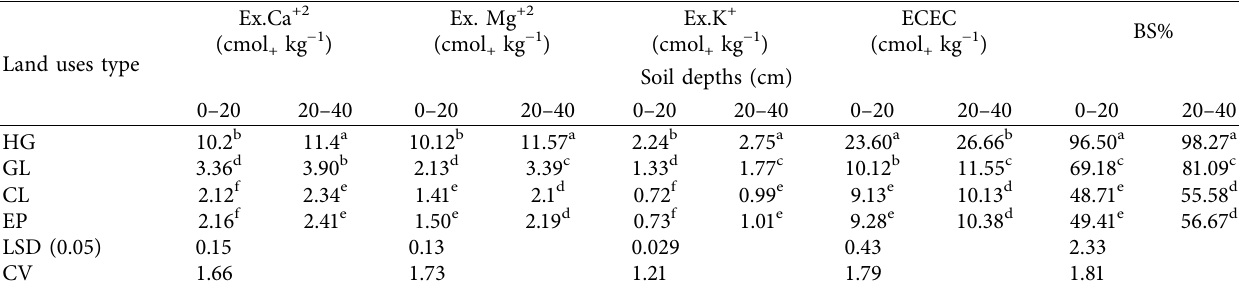
Table 5: Te interaction efects of land use and soil depth on soil exchangeable cations, efective cation exchange capacity, and base saturation percentage of the soils in the Hojje watershed ( N �